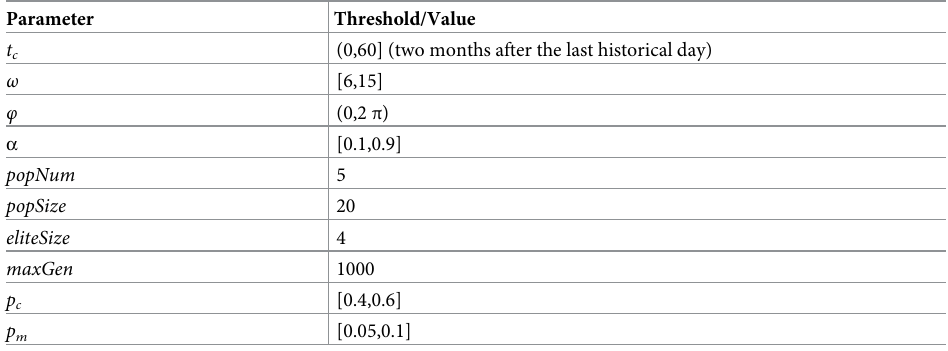
Table 1. Parameter values and thresholds used in the